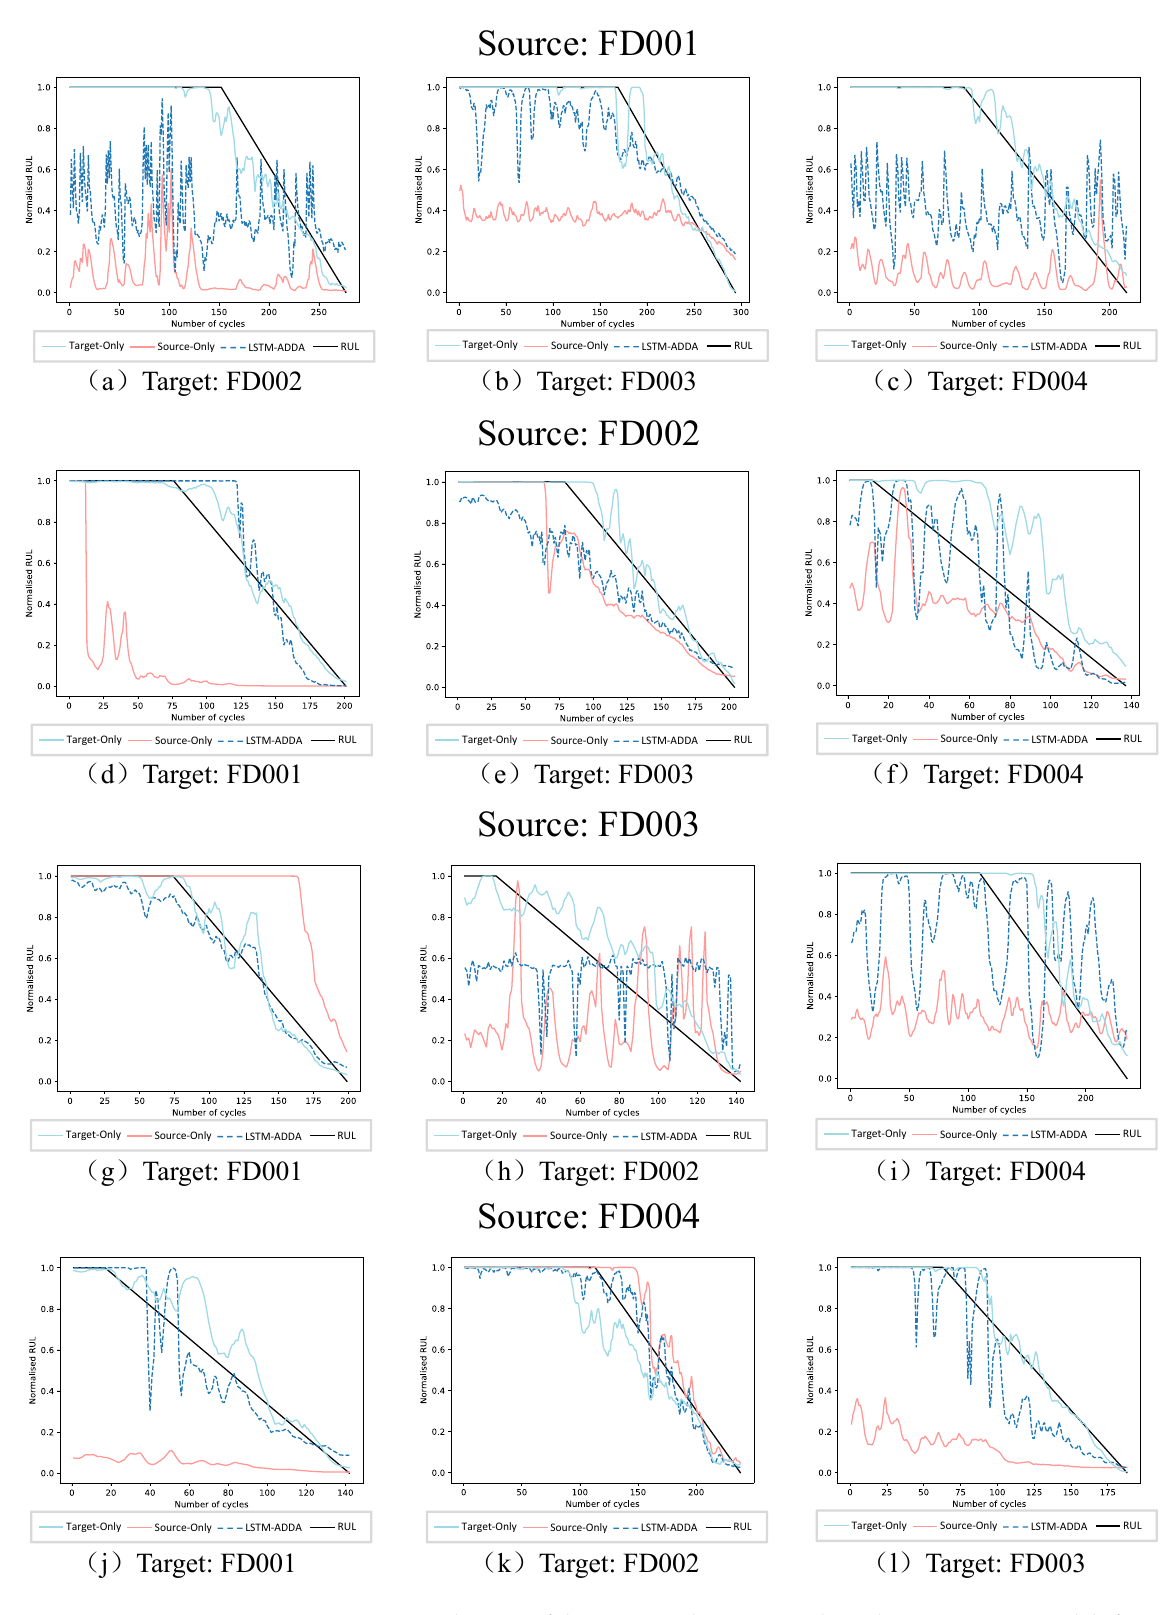
Figure 6. RUL predictions of the Target-only, Source-only and LSTM-ADDA models for one target testing